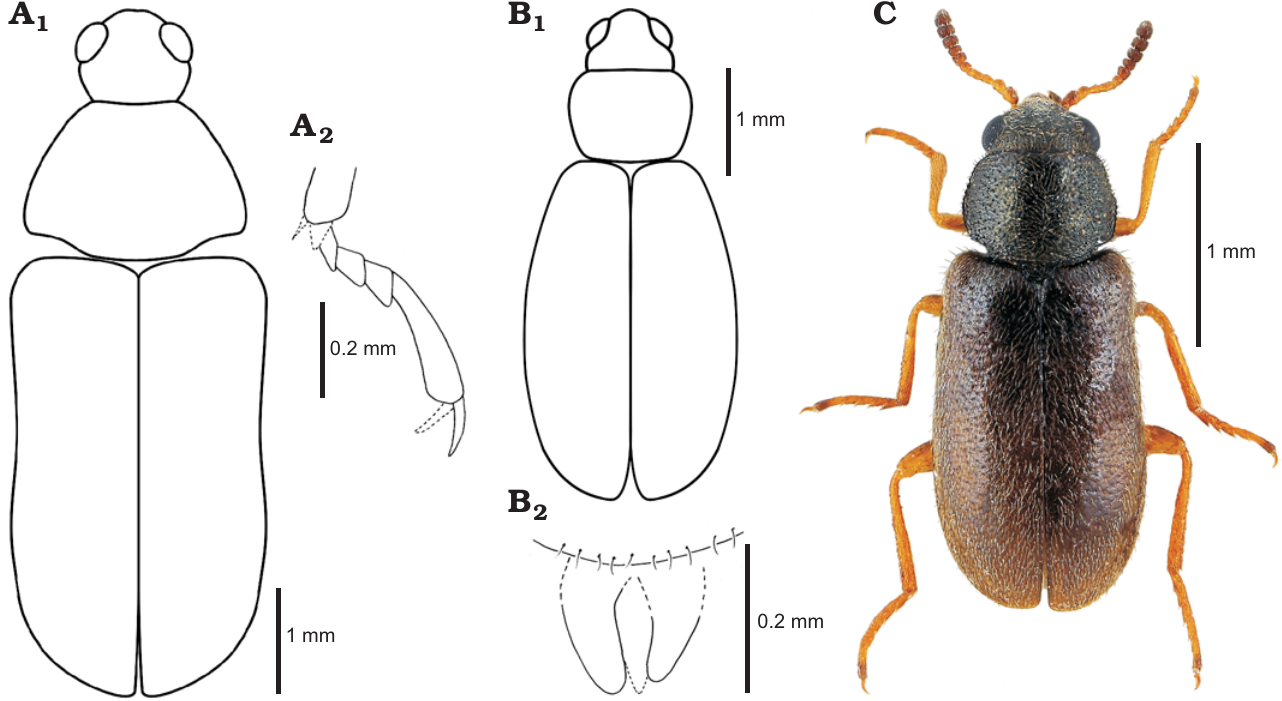
Fig. 4. Melyrid beetle Sinomelyris praedecessor gen. et sp. nov. (A), cleroid beetle Juraniscus majeri gen. et sp. nov. (B) from the Middle Jurassic, Haifanggou Formation of Daohugou Village, Inner Mongolia, China, and extant mauroniscid beetle Mauroniscus titschacki Pic, 1954 (C) from Cuzco, Peru. A . NIGP168477; reconstruction of body shape (A 1 ), mesotarsus laterally (A 2 ). B . NIGP168479; reconstruction of body shape (B 1 ), assumed apex of aedeagus dorsally (B 2 ). C . MMBC-SC, dorsal